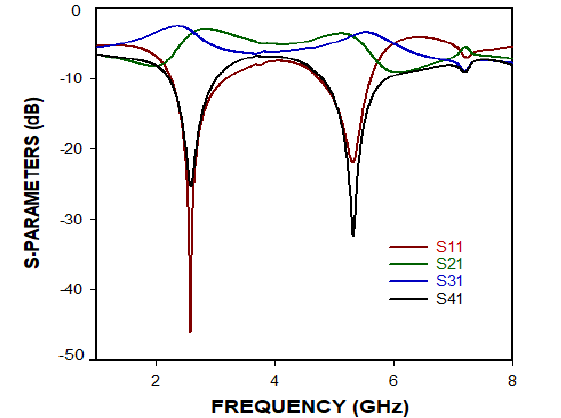
Fig. 8. Proposed dual-band patch coupler